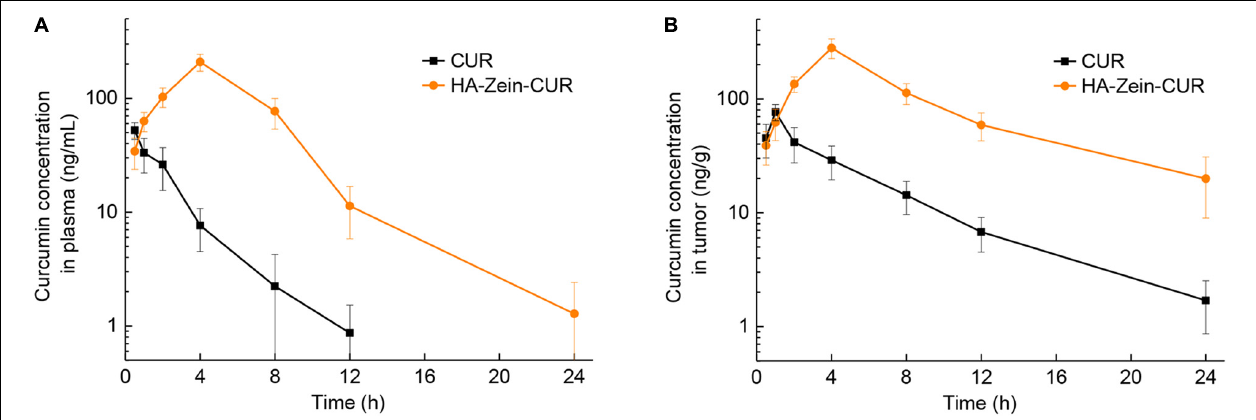
FIGURE 6 | Pharmacokinetics analysis of free CUR and HA-Zein-CUR in mice. (A) Plasma and (B) tumor concentration profiles of CUR in mice following intragastric administration of free CUR and HA-Zein-CUR, respectively. Values are mean ± SD, n = 3.